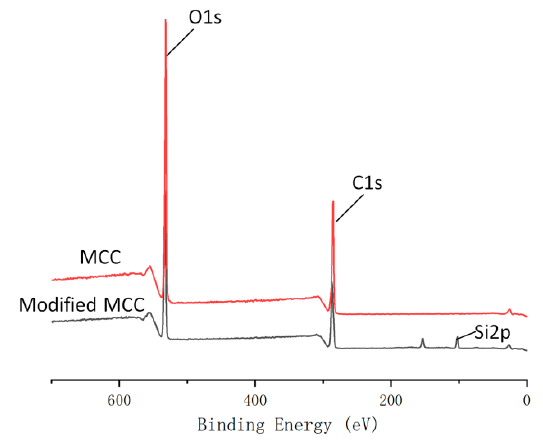
Figure 7. XPS spectra of unmodified MCC and modified MCC. Table 4. The surface elements and functional groups distribution of MCC determined by XPS.